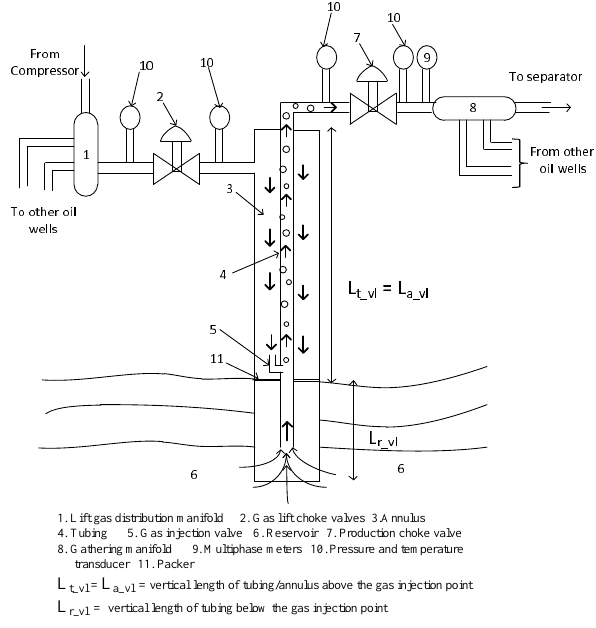
Figure 3: Di(cid:27)erent components of a gas lifted oil well The compressor outputs a highly pressurized lift gas into the gas distribution pipeline. The lift gas enters into the annulus of each well from this common gas distribution manifold. The amount of lift gas to be injected into each well is controlled by the gas lift choke valve present in the well head of each oil well. jected into the tubing at a proper depth through the gas injection valve (see Figure